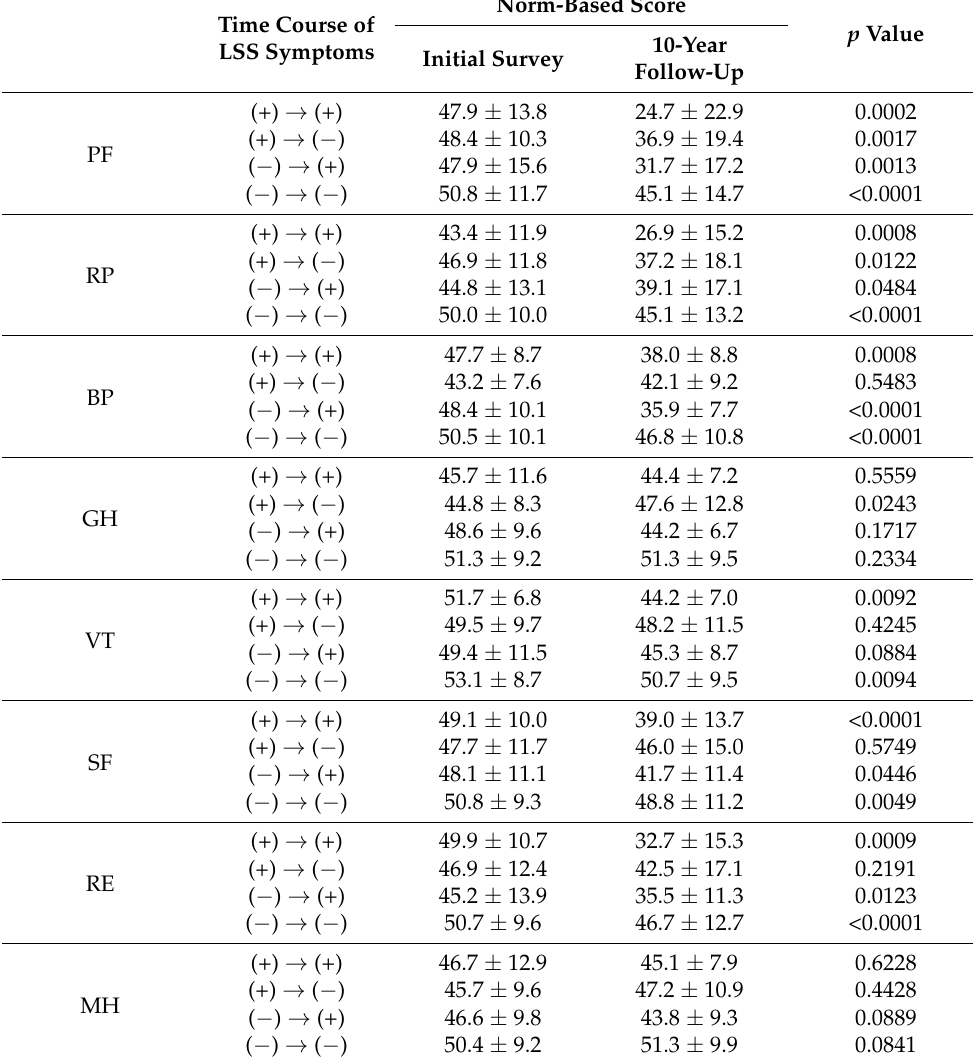
Table 4. Time course of LSS symptoms and eight domains of SF-36 norm-based score. Norm-Based Time Course of LSS Symptoms